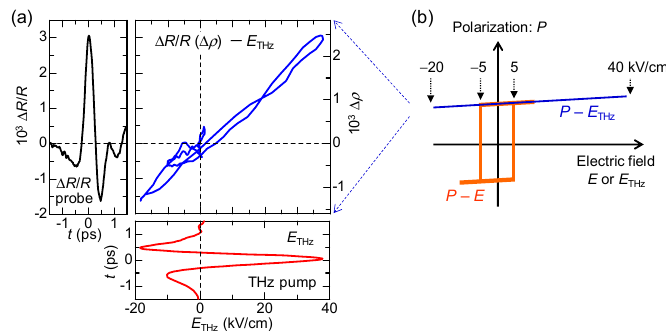
Figure 22. Comparison of ferroelectric polarization P and terahertz electric field E THz in TTF-CA [41]. ( a ) Interrelation in time evolutions of a reflectivity change Δ R / R ( Δρ ) and E THz at 65 K; ( b ) Schematic of a polarization–electric field curve ( P – E curve) and a polarization–terahertz-electric-field curve ( P – E THz curve).